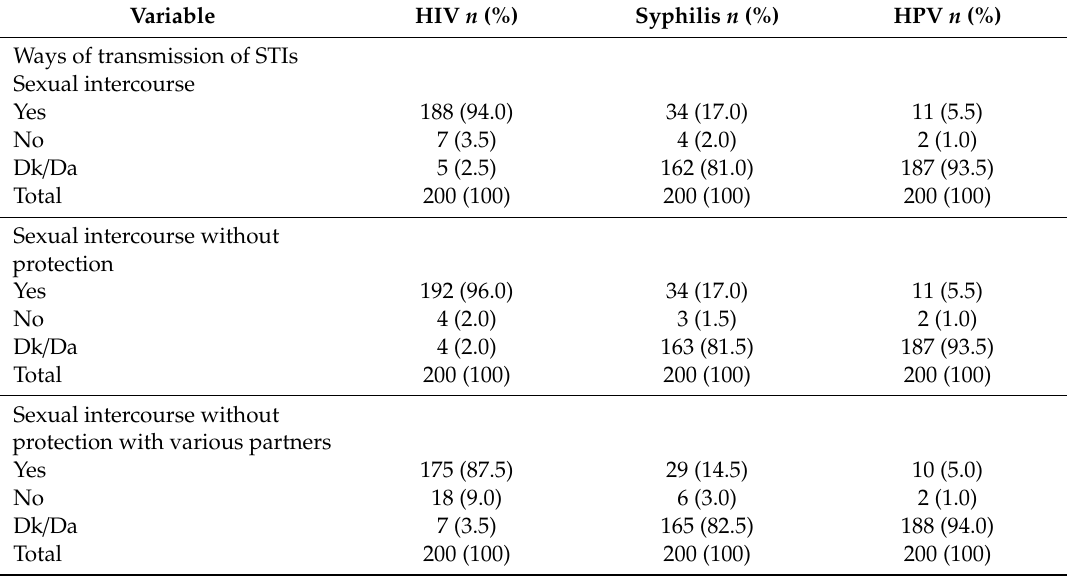
Table 3. Respondents’ knowledge of transmission, prevention, and testing of sexually transmitted infections